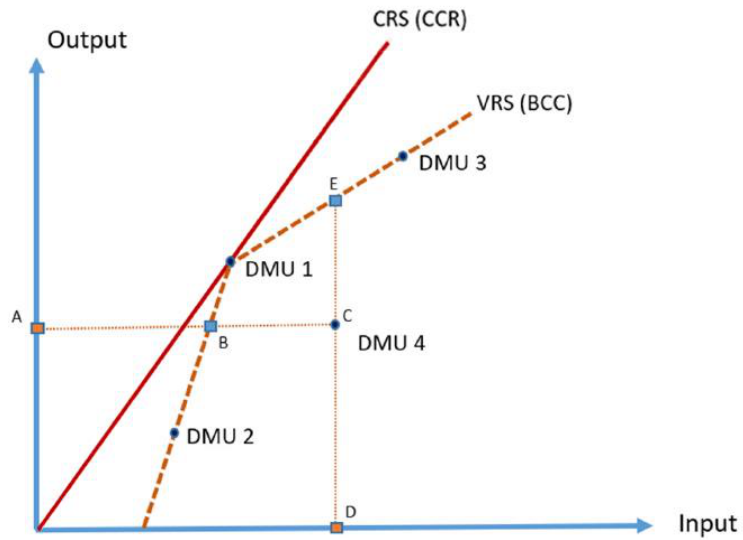
Figure 2. An illustration of DEA and its diversification, adapted [27].